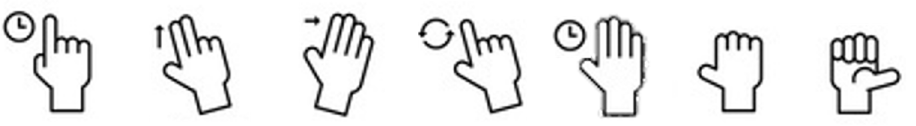
Figure 7. Various gesture definitions for recognition.